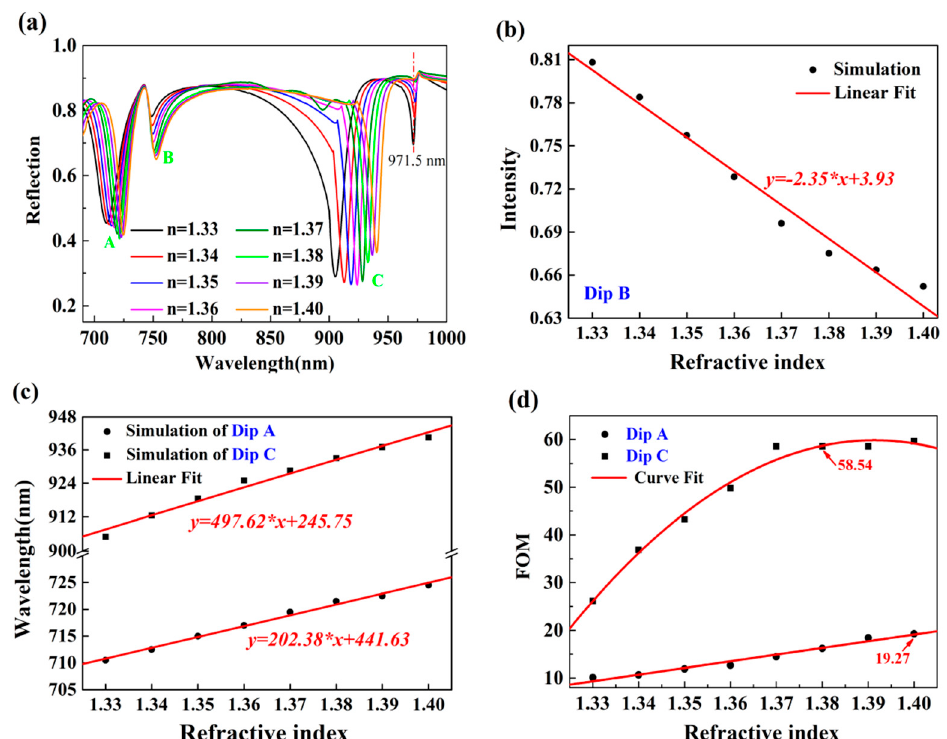
Figure 8. Sensing performances of proposed double-layer plasmonic grooves at incident angle 65°. ( a ) The relationship of sample refractive index (RI) and relative intensity of dip B. ( b ) The relationship of sample RI and resonance wavelength of both dips A and C. ( c ) Figure of merits (FOM) for resonant modes of both dips A and C.